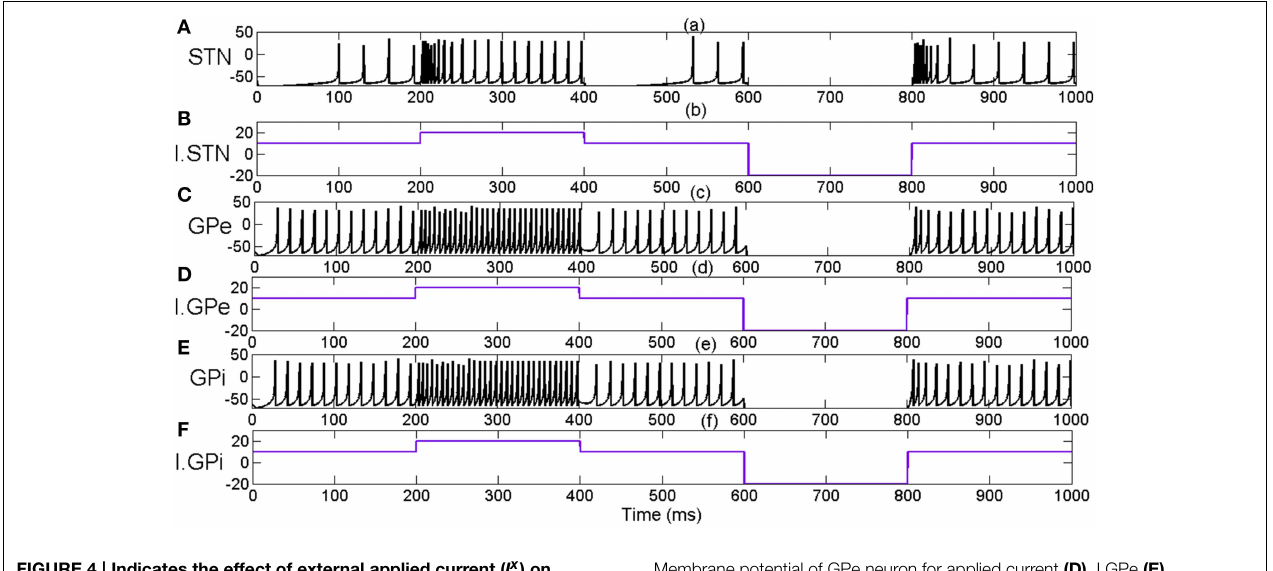
Membrane potential of GPe neuron for applied current (D) , I.GPe (E) Membrane potential of GPi neuron for applied current (F) , I.GPi. X-axis indicates the time of simulation in